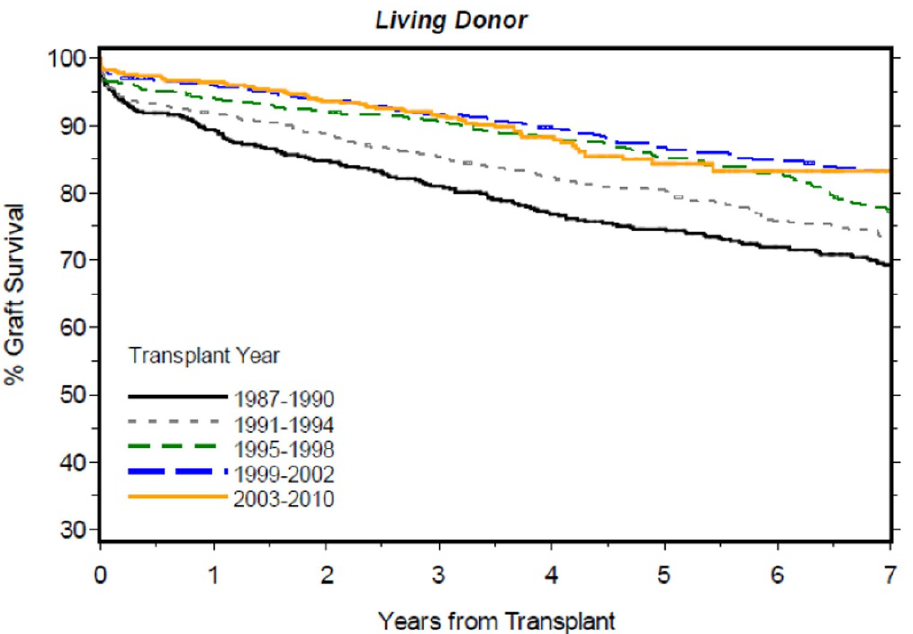
Figure 1 - Renal allograft survival after living donor transplantation by era. Taken from the NAPRTCS 2011 Annual Report